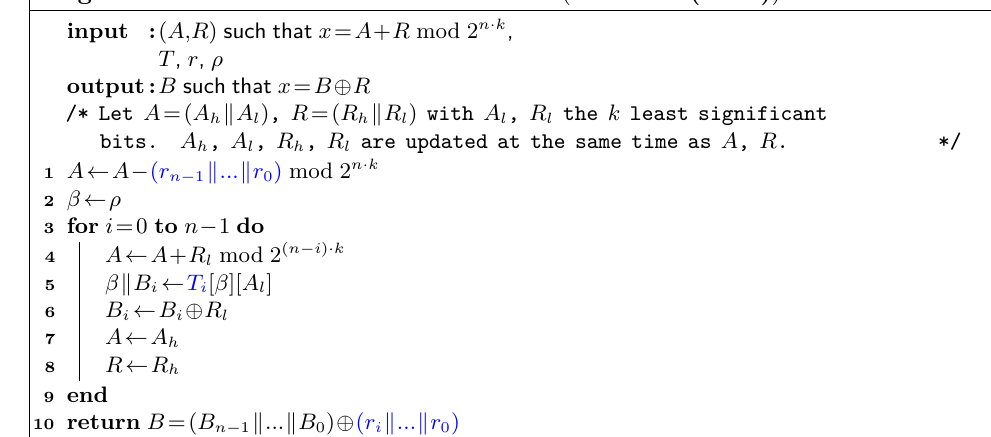
Algorithm 8: Conversion of a n · k -bit variable ( Debraize (fixed)